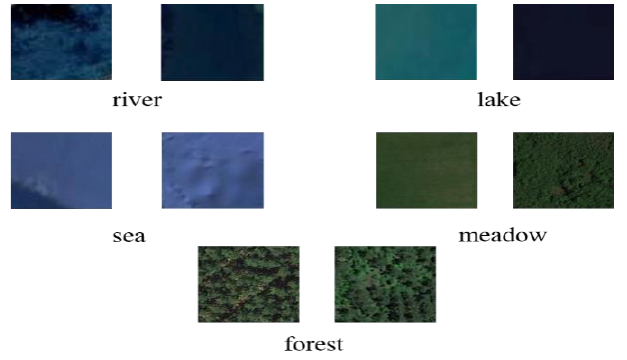
Figure 2. The texture samples from five classes in the data